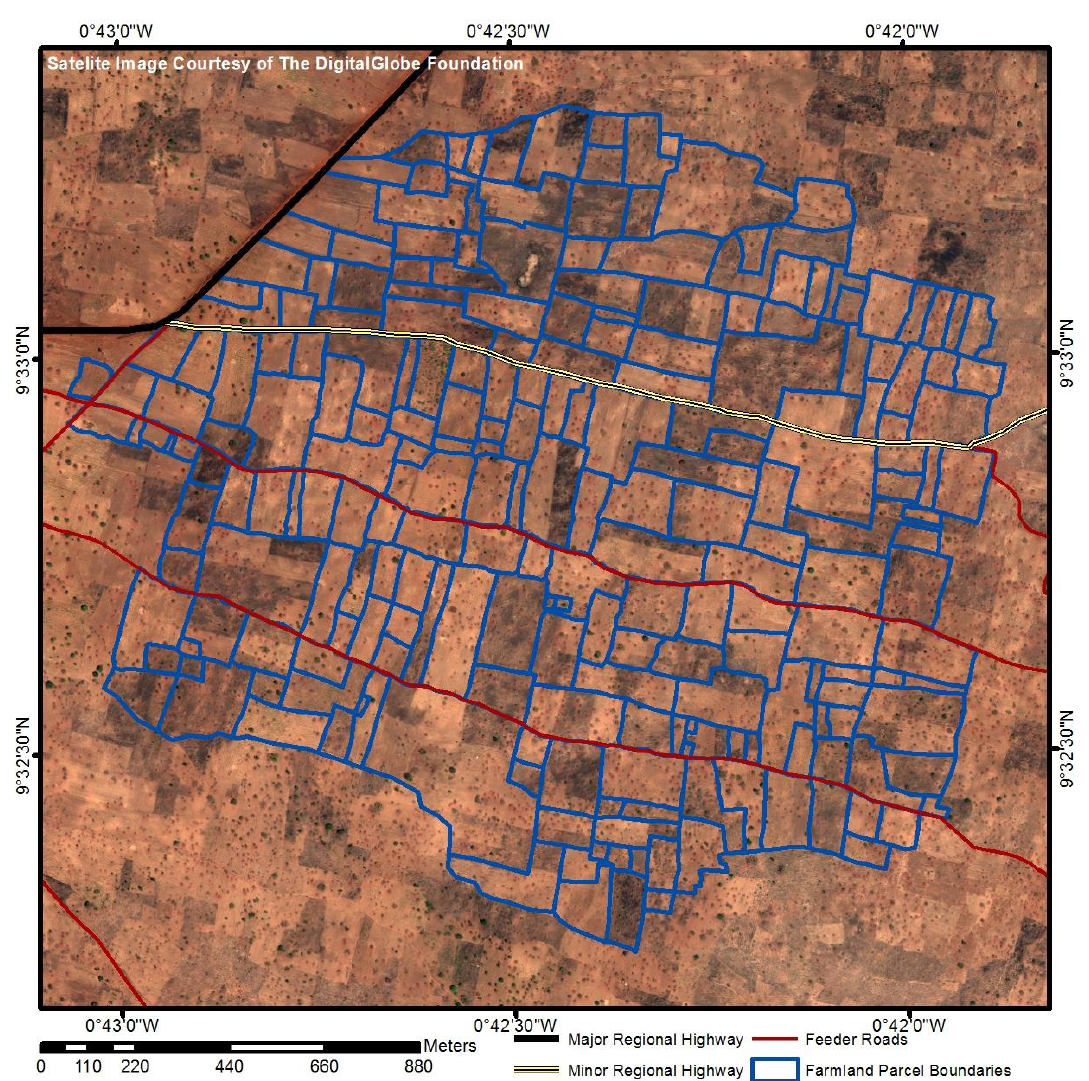
Figure 6. Parcel arrangement in the area of interest — Nanton collected by PLA.